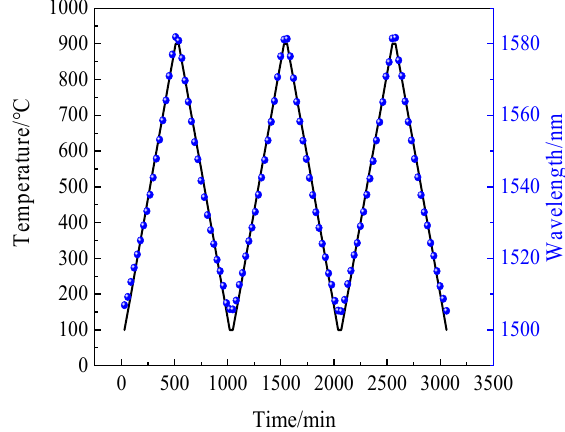
Figure 18. Three heating and cooling repeats of the 1506 nm dip.